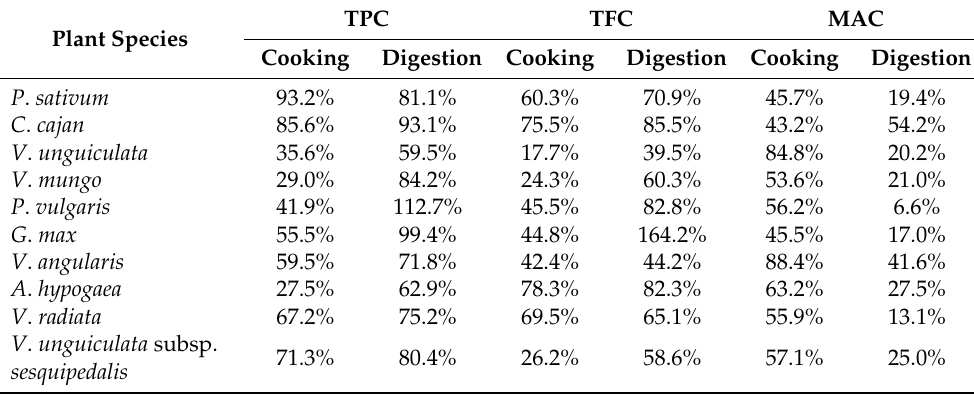
Table 3. Evolution of daidzein and genistein contents before (uncooked), and after traditional cooking (cooked) and after traditional cooking followed by in vitro gastro-intestinal digestion (in vitro Digestion) from beans from ten Fabaceae species.